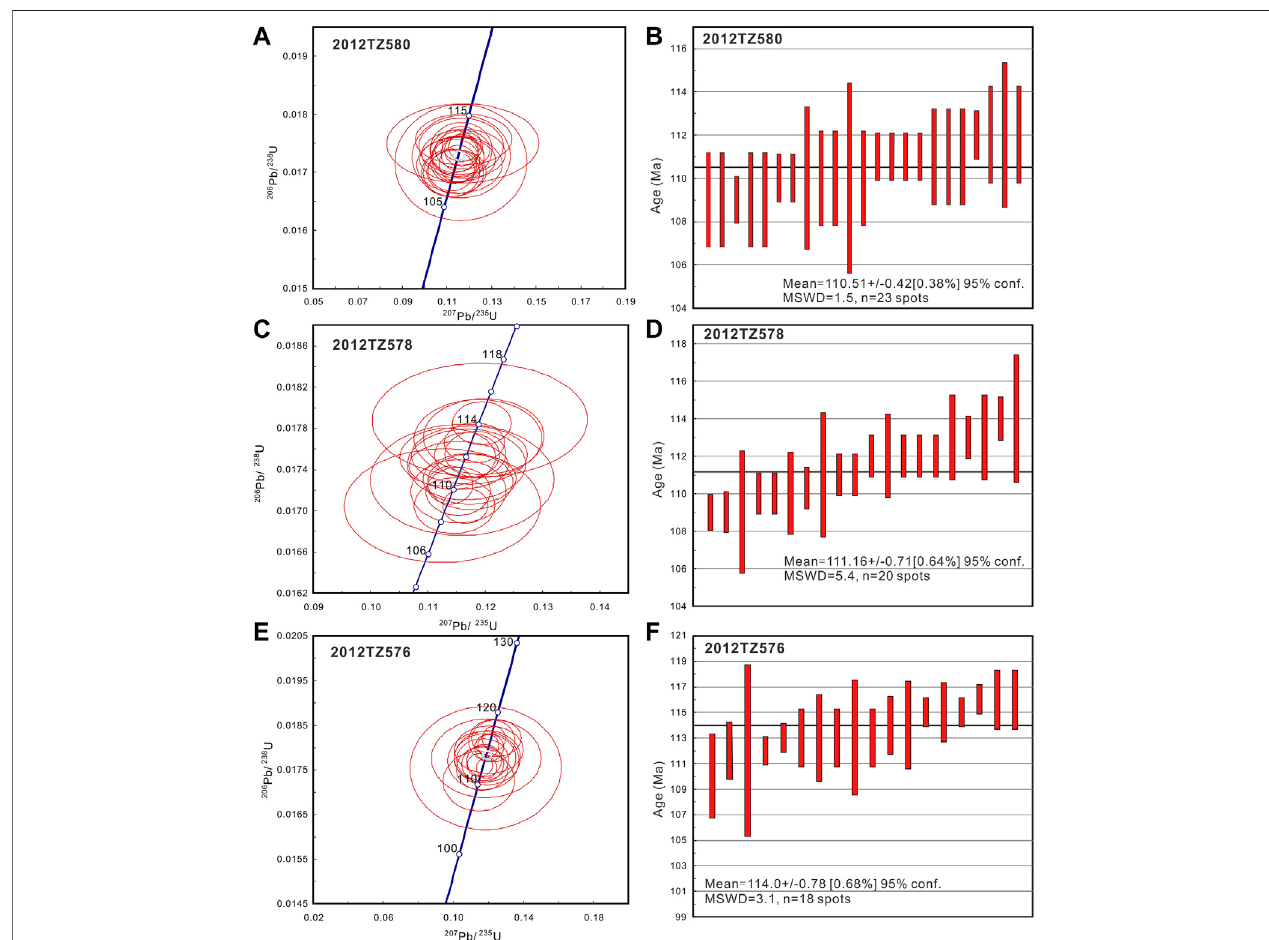
FIGURE3| Diagramsshowingconcordantages(leftcolumn)andweightedmeanages(rightcolumn)fordatingsamplesoftheZonggeiFormationvolcanicrocksin this study. (A,B) Concordant and weighted mean ages for U-Pb dating results of the sample 2012TZ580, collected from the Zonggei Formation volcanic rocks near paleomagnetic siteTNZ01 (see Figure2D for details). (C,D) Concordantand weightedmean ages forU-Pb datingresults ofthesample 2012TZ578, collectedfrom the Zonggei Formation volcanic rocks near paleomagnetic site TNZ04 (see Figure 2D ). (E,F) Concordant and weighted mean ages for U-Pb dating results of the sample2012TZ576,collectedfromtheZonggeiFormationvolcanicrocksnearpaleomagneticsiteTNZ13(see Figure2D ).SeeSupportingInformation Supplementary Table S2 for detailed data on the U-Pb isotopic compositions and dating